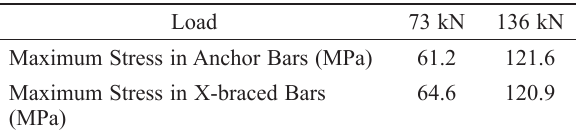
Table 4. Stresses in Load Phases